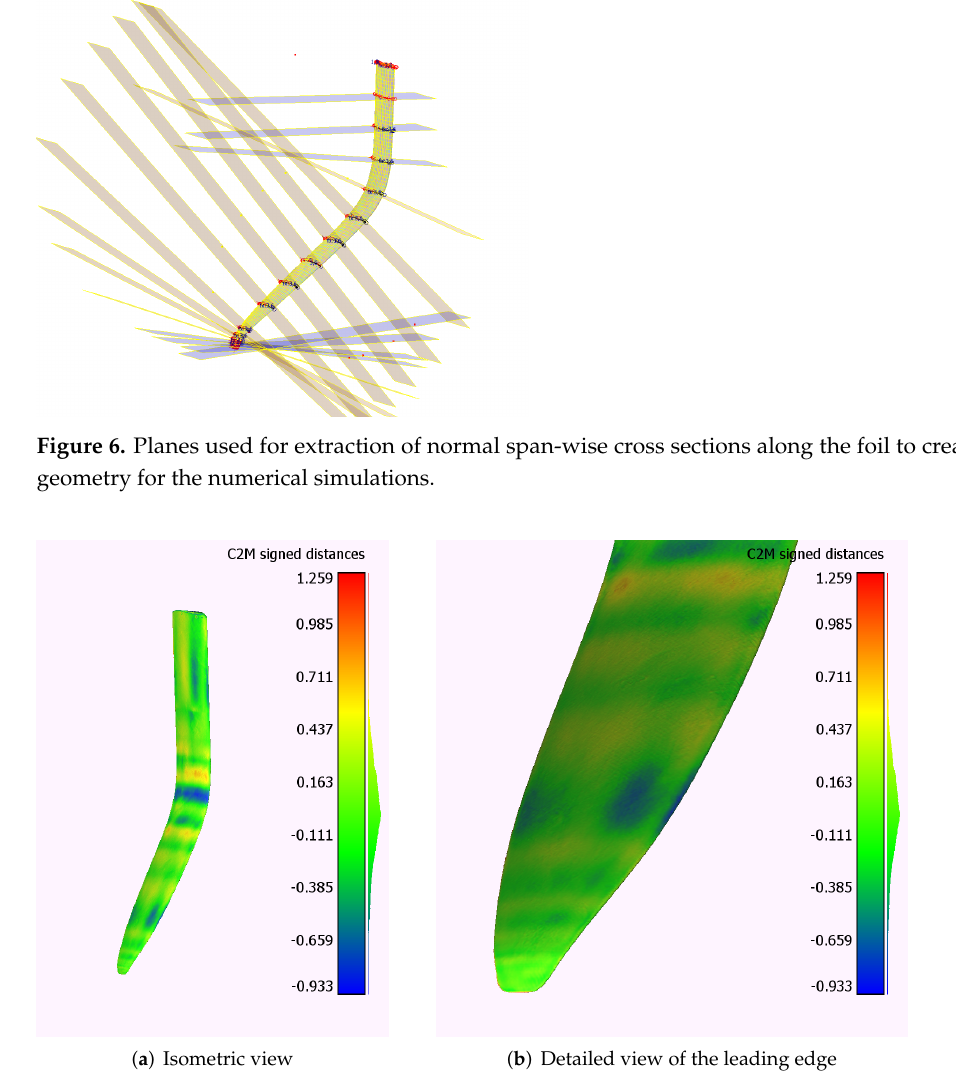
Figure 7. Cloud to mesh (C2M) of the NACRA 17 Z-Foil geometry as designed with cross-section planes and lofting compared to 3D-scan with differences presented in